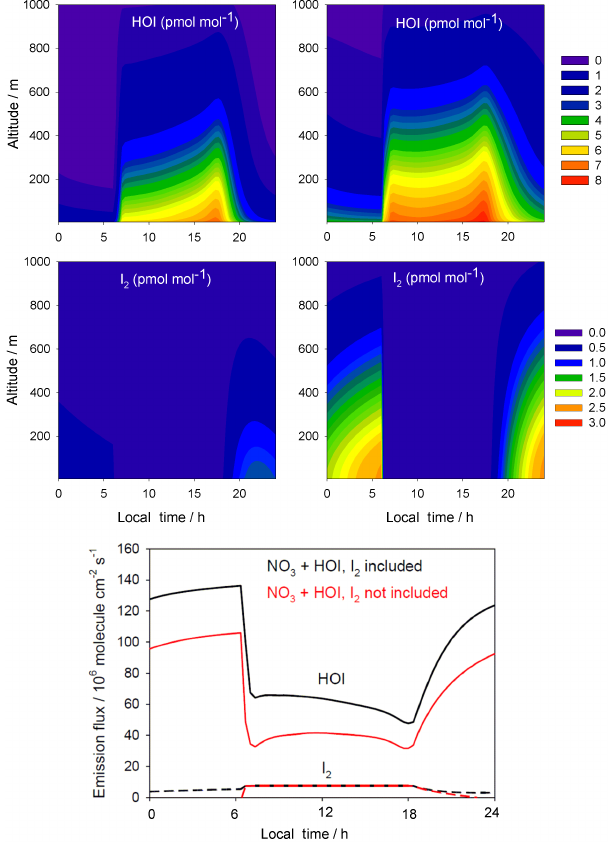
Figure 5. THAMO modelled diurnal variation of IO, NO 3 and the IONO 2 . The right-hand panels are from Scenario 1, which do not include nighttime reactions of HOI and I 2 with NO 3 , while the left- hand panels include the reactions in Scenario